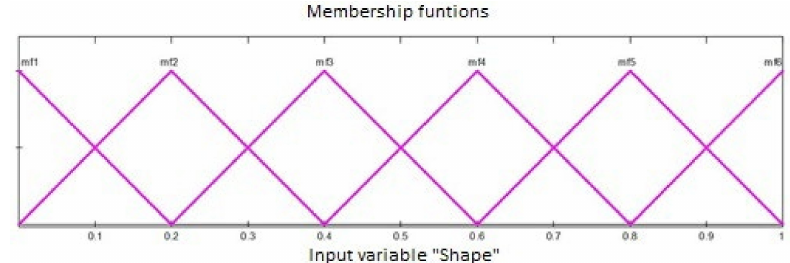
Figure 17. MFs of the input variable “Shape”.